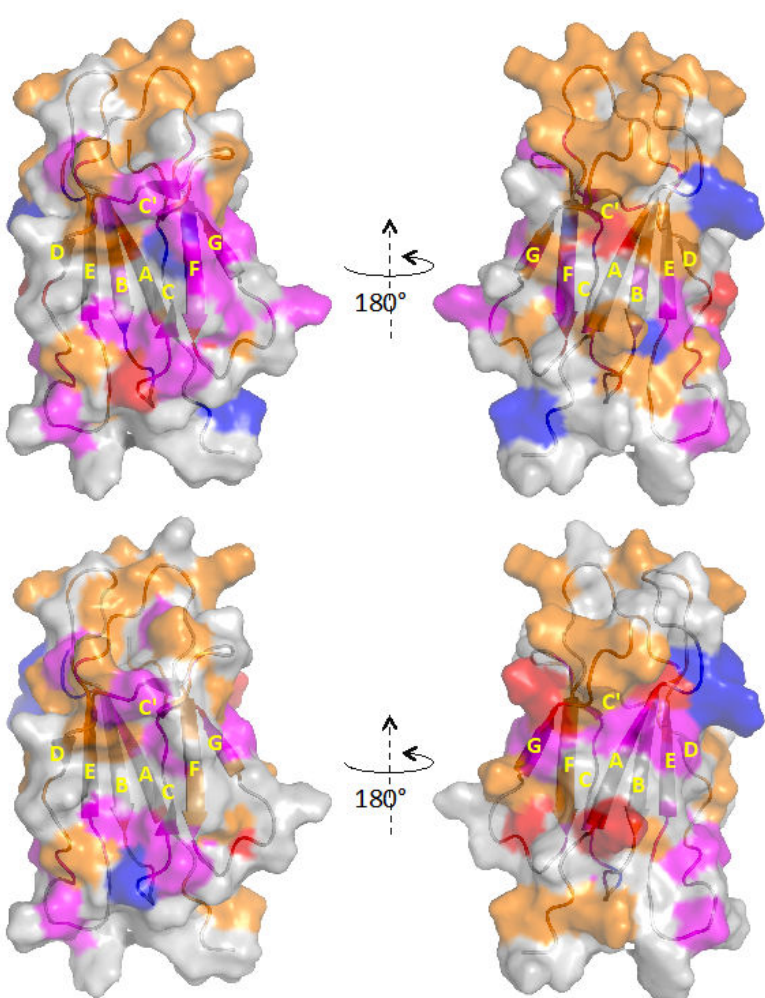
Figure 3. Cartoon representation of β 2m surface sampled by Tempol in the absence ( upper pair ) and presence ( lower pair ) of AuNPs. The positions of the accessible backbone amides, i.e., exhibiting A N [eq] > 1, are marked in red. The locations of the amides with Type I or Type II deviation of A N [o ff -eq], i.e., displaying A N [o ff -eq] > A N [eq] or A N [o ff -eq] < A N [eq], are highlighted in orange or blue, respectively. The magenta color denotes sites where both A N [eq] > 1 and Type II deviation occur simultaneously. The very few positions where A N [eq] > 1 and Type I deviation coincide were left in orange. The secondary structure elements of β 2m are indicated according to the crystallographic naming scheme (PDB code